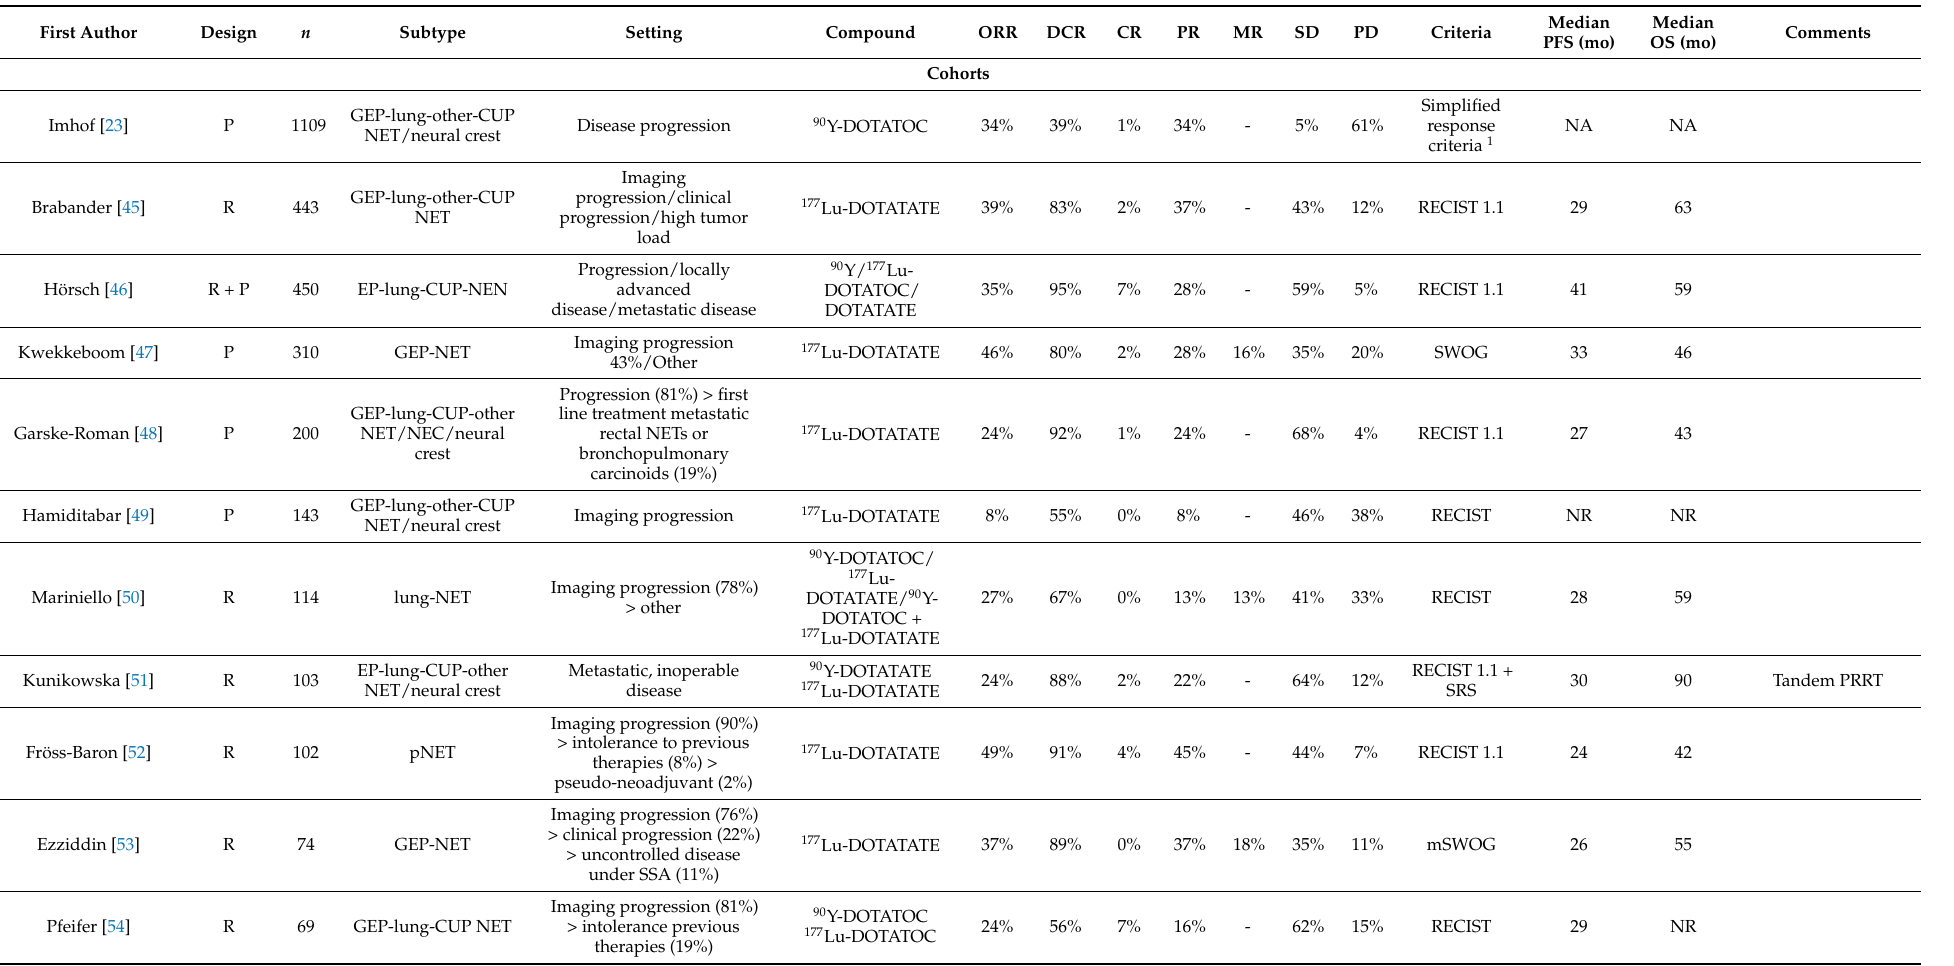
Table 2. Efficacy and outcome in